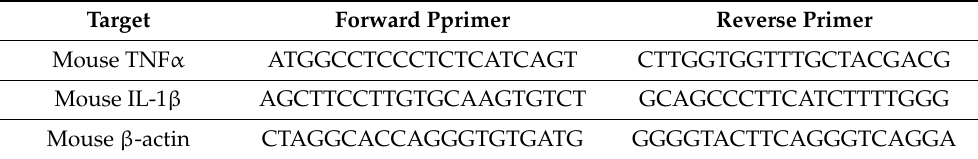
Table 1. Primers used for this